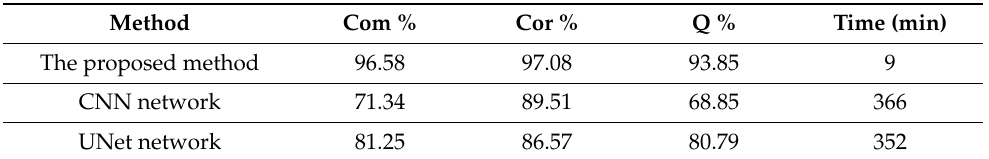
Table 2. Results of the di ff erent methods.